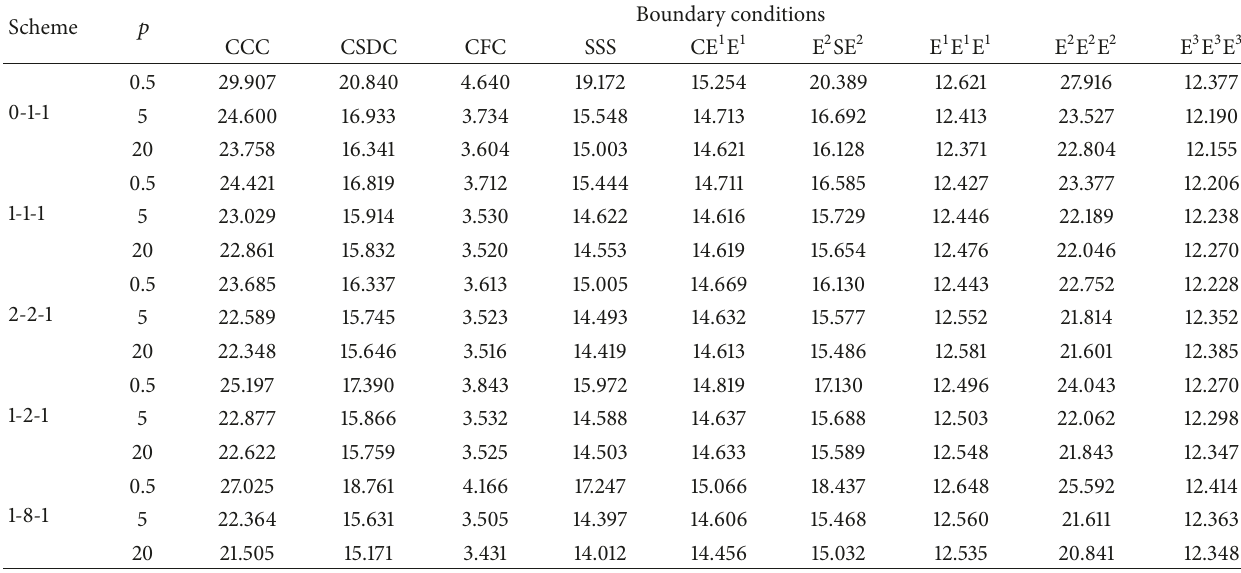
Table 12: Fundamental frequency parameter Ω for Type 2-2 circular sector plate with various boundary conditions ( ℎ/𝑅 1 = 0.2, 𝑝 2 = 𝑝 , and 𝜙 = 350 ∘